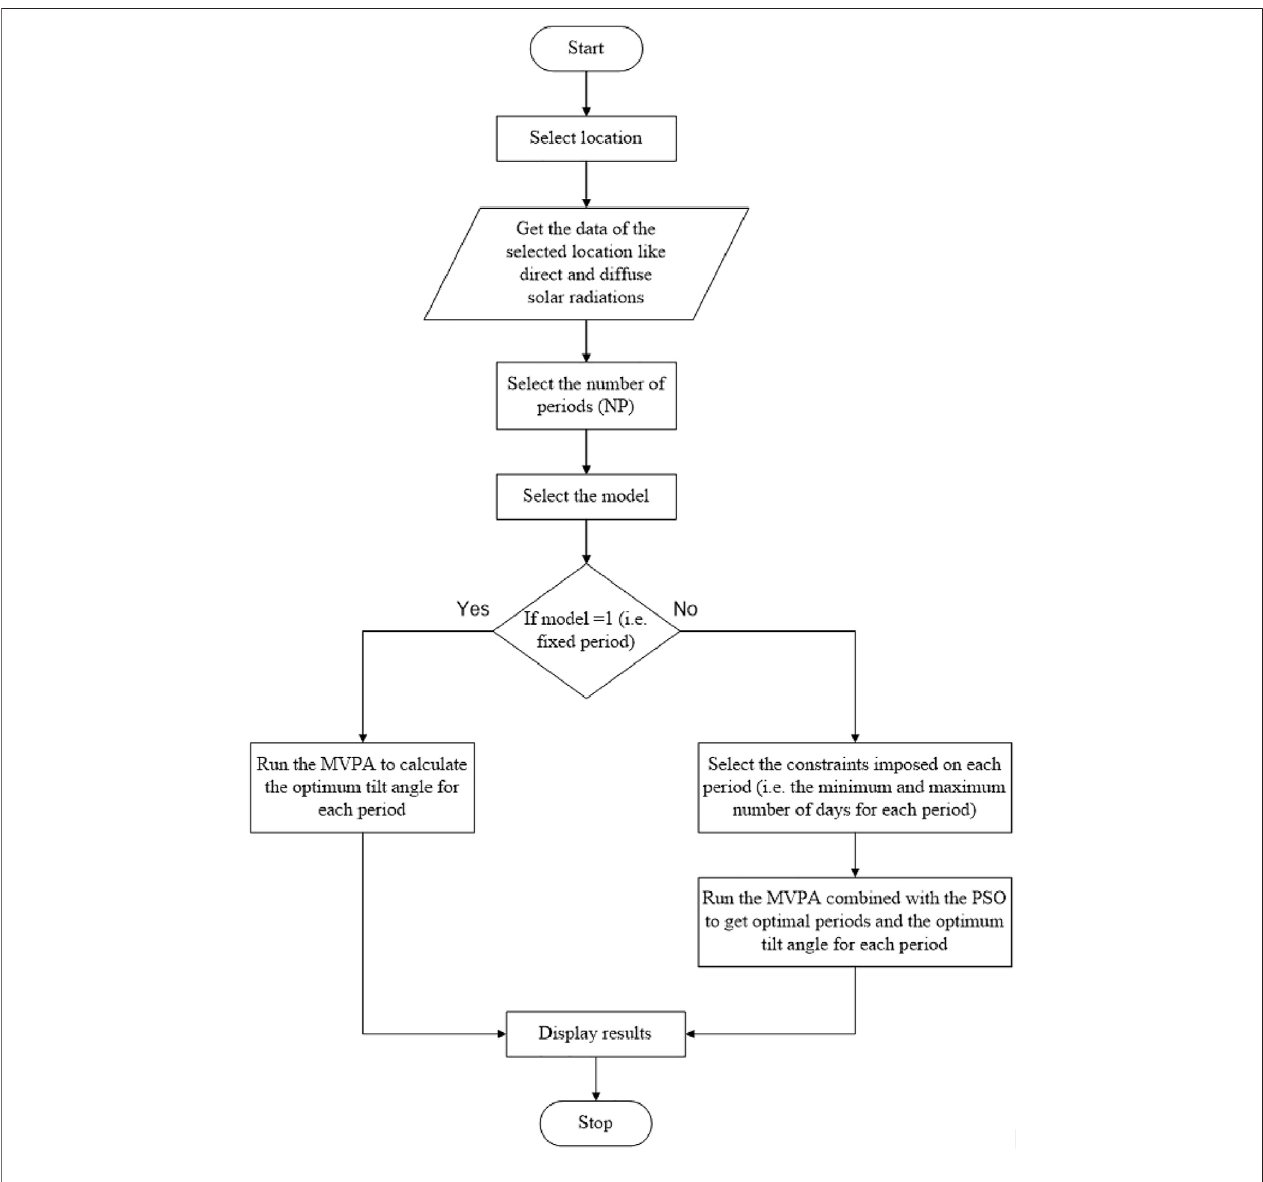
FIGURE 1 | Flowchart for the proposed